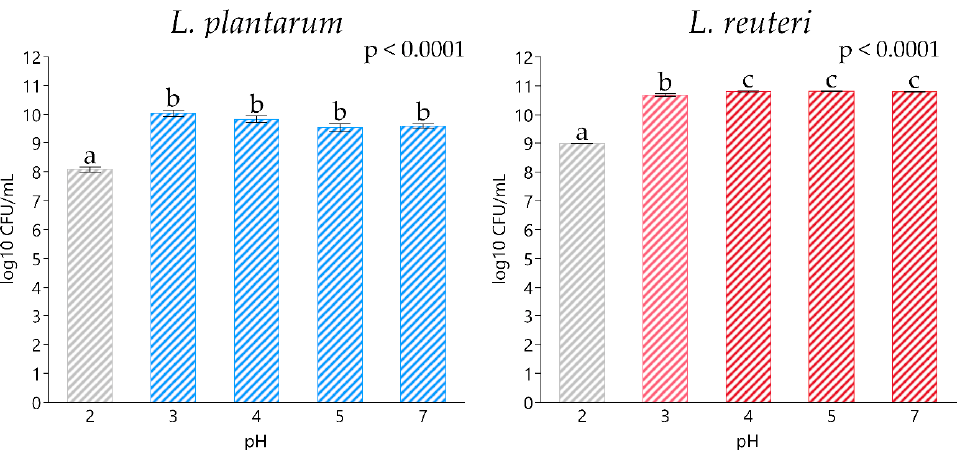
Figure 1. Acid resistance assay from pH 2 to 7 for L. plantarum and L. reuteri . Data are expressed as least square means (LSMEANS) and standard errors (SE). a,b,c Means with different superscript letters indicate statistically significant differences ( p < 0.05).